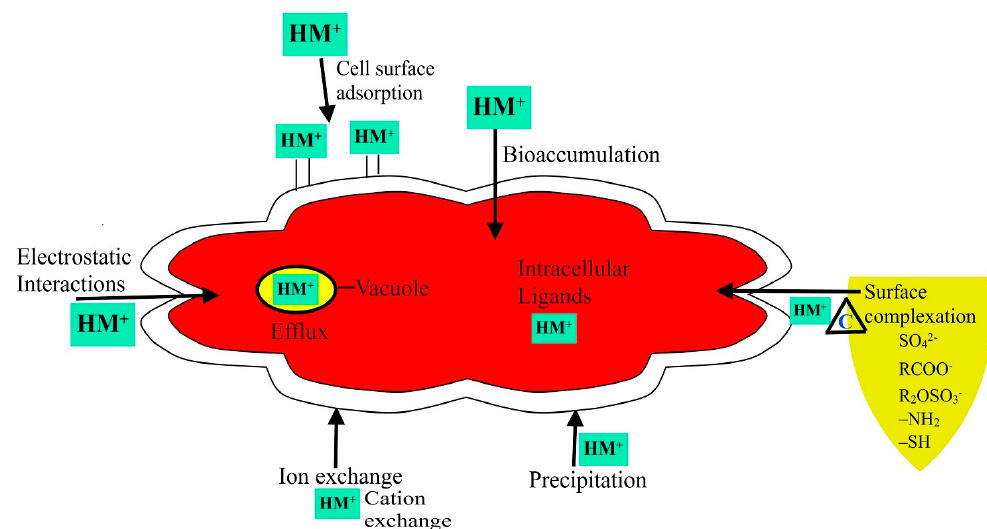
Figure 1. Mechanisms of heavy metal uptake by microorganisms.